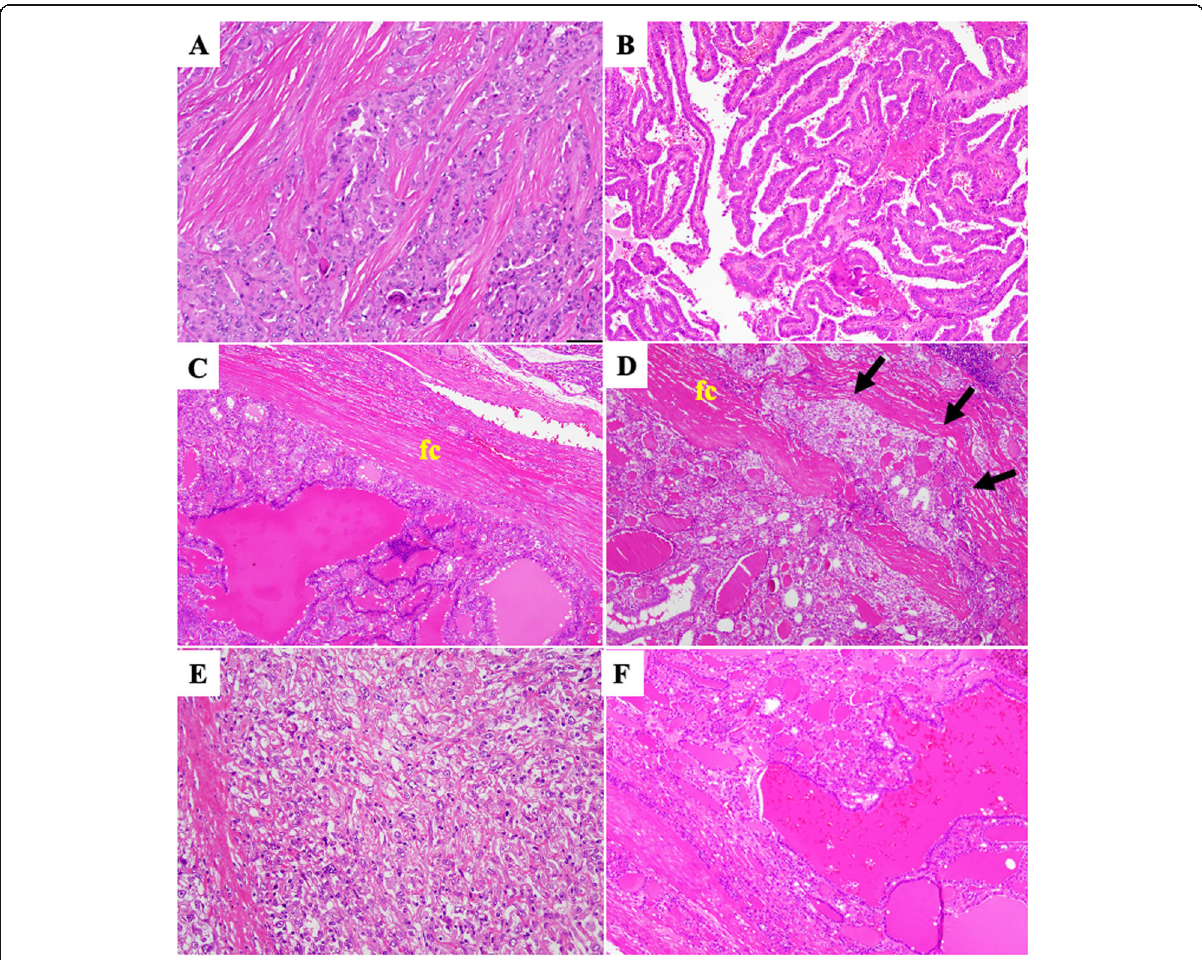
Fig. 1 Histology of thyroid nodules. A Microcarcinoma (H&E). The nuclei of tumor cells showed a ground glass-like appearance, and tumor cells were surrounded by a sclerotic stroma. B Papillary carcinoma (H&E). Tumor cells, whose nuclei exhibited a ground glass-like appearance, formed irregular papillary structures. C Follicular adenoma (H&E). Follicles composed of tumor cells that exhibited mild nuclear atypia, but not capsular invasion, were observed (fc, fibrous capsule). D Minimally invasive follicular carcinoma (H&E). Tumor cells that exhibited mild atypia invaded the fibrous capsule (fc, fibrous capsule; arrows, capsular invasion). E Undifferentiated carcinoma (H&E). Polymorphous atypical short spindle-shaped cells that exhibited loose cell-cell adherence were arranged in fascicular structures or diffusely distributed. F Adenomatous goiter (H&E). Hyperplastic follicular cells without atypia were detected. Follicles contained colloid